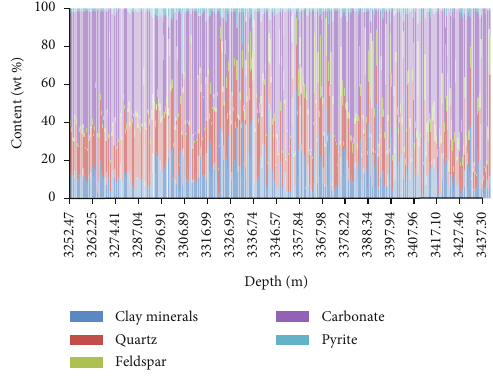
Figure 4: The main mineral contents of the Es4u shale in the Dongying Depression.